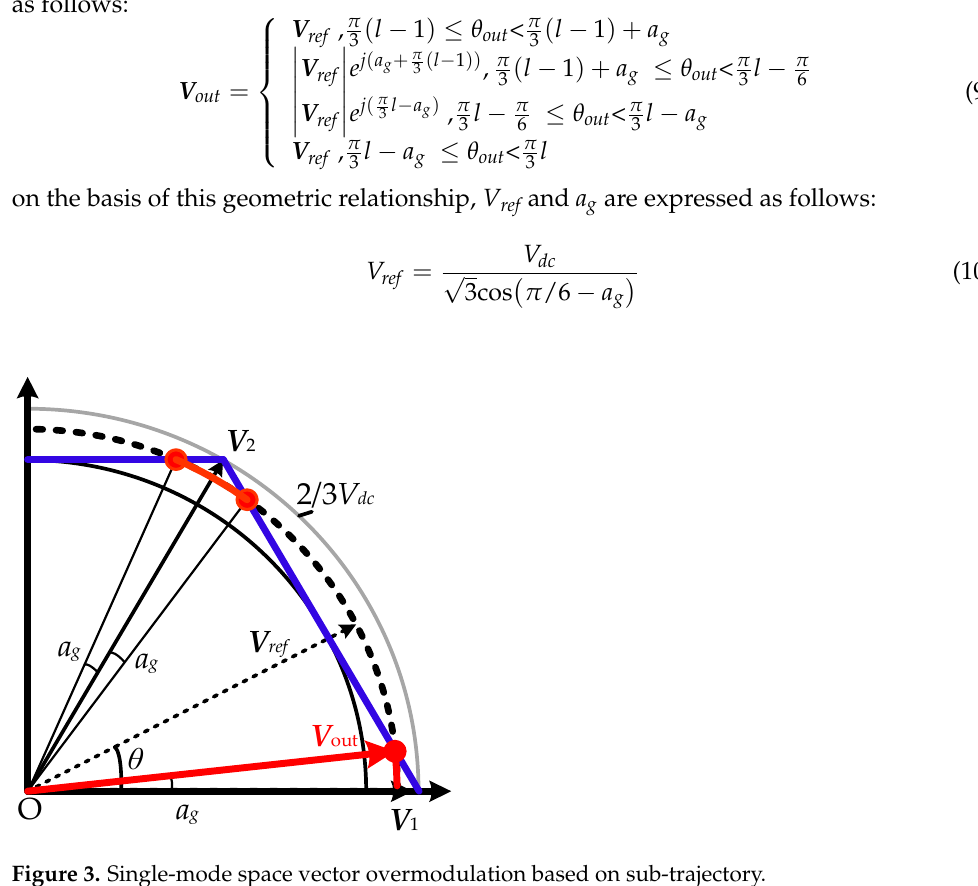
Figure 3. Single ‐ mode space vector overmodulation based on sub ‐ trajectory. Figure 3. Single-mode space vector overmodulation based on sub-trajectory.